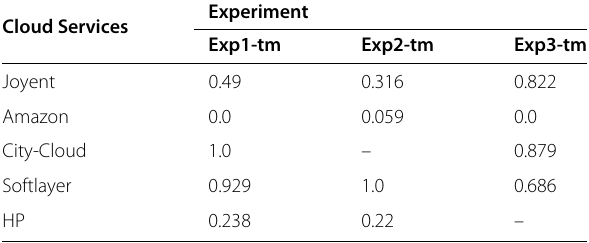
Table 15 Total Measure for Each